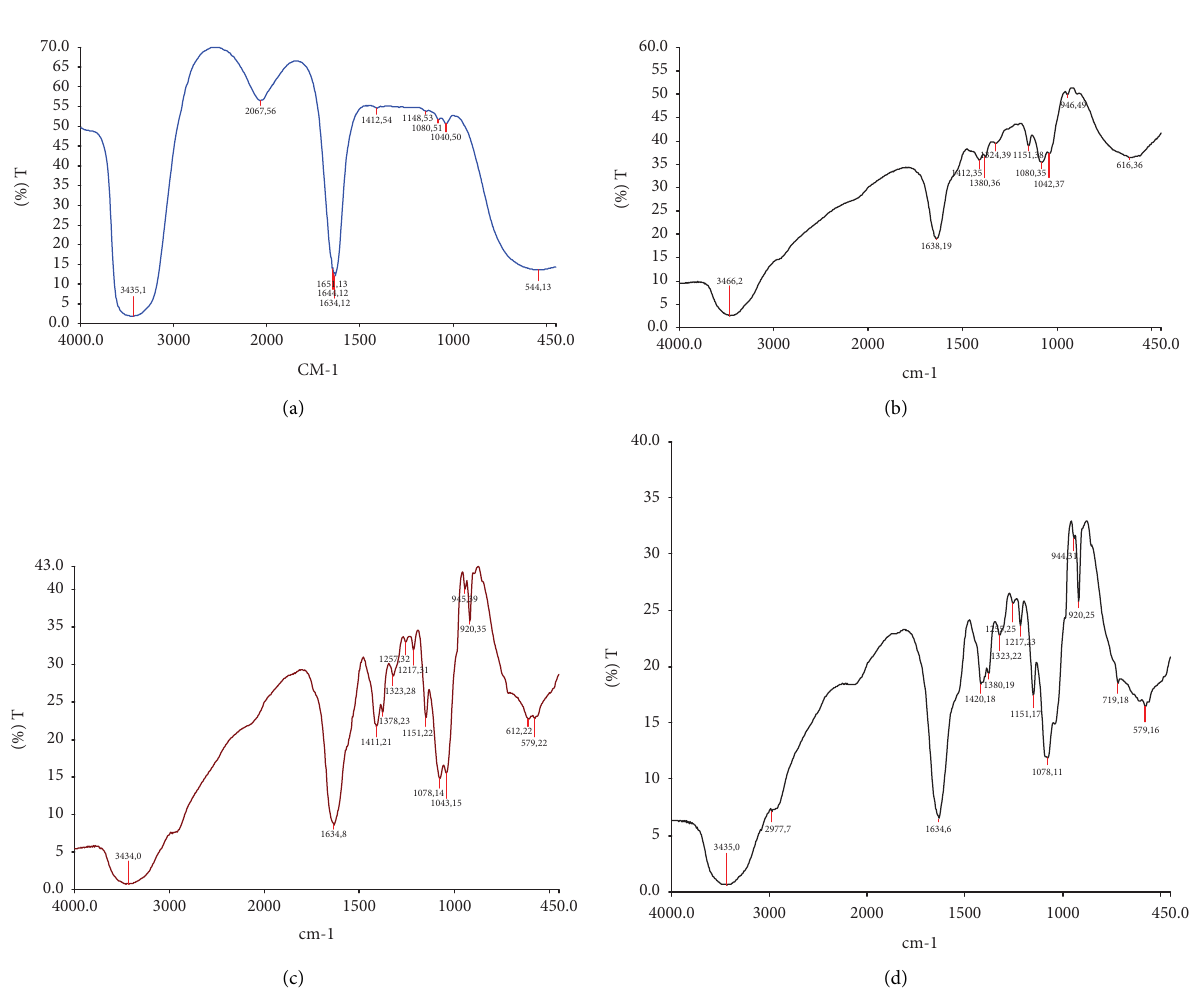
Figure 1: FTIR spectra of hyaluronic acid (HA): chitosan hydrogel with varying composition HA: chitosan sample (a) (30: 0mg/ml), sample (b) (30:10 mg/ml), sample (c) (30: 20mg/ml), sample (d) (30: 30mg/ml).